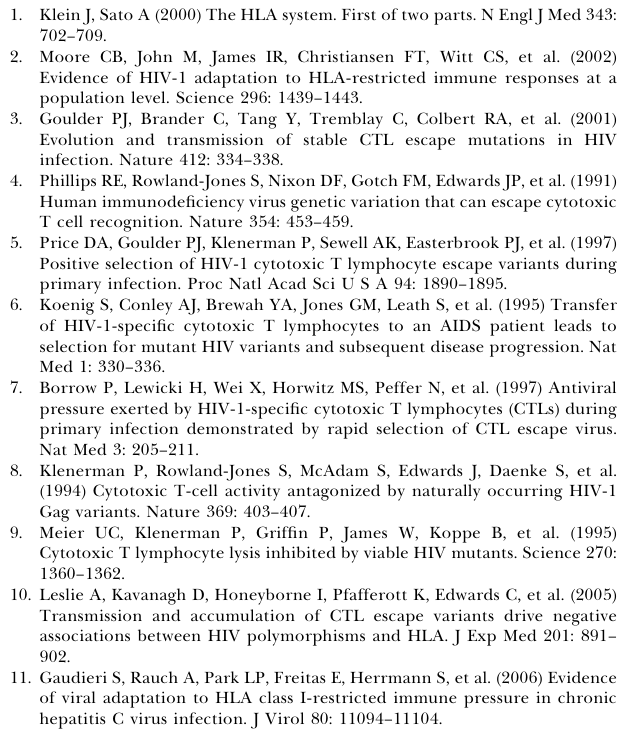
Figure S1. Illustration of a Case where an Apparent HLA-Associated HIV Amino Acid Variation Pattern Is an Artifact of the Phylogenetic Tree, and Using a Phylogenetic Correction Avoids an Incorrect Assignment of an HLA Driven Association